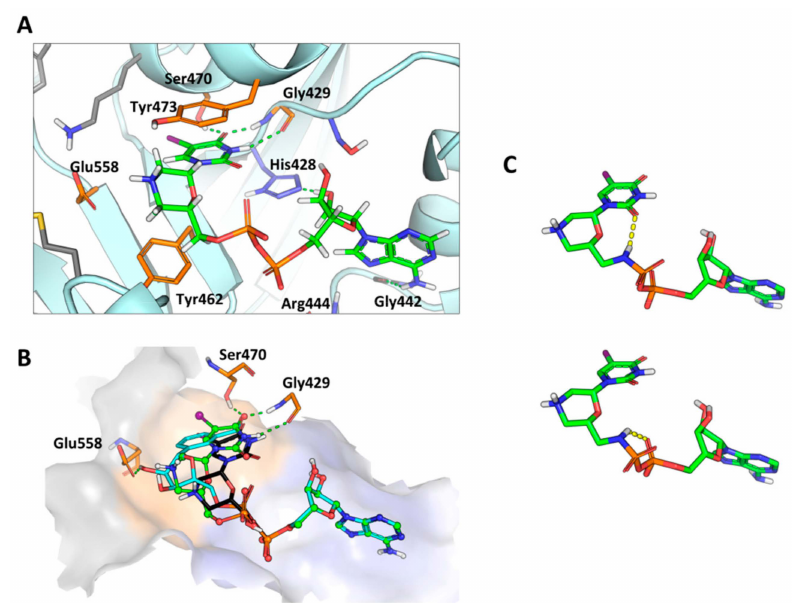
Figure 7. Predicted binding mode of 10IU with the donor binding site of the PARP-2 catalytic domain. ( A ) The close-view of the donor binding site. ( B ) Structural alignment of the binding poses of 10IU (green color) with NAD + (cyan color) and 5-I-Urd (black color). ( C ) Representative conformations of 10IU from the molecular dynamics trajectory, the conformation with the intramolecular hydrogen bond with the non-bridging α -phosphate oxygen of ADP (bottom) and the conformation with the hydrogen bond with carbonyl oxygen of the heterocyclic base of the modified nucleoside (top) are shown. The molecular surface of the binding site is shown. Hydrogen bonds are depicted as green dashed